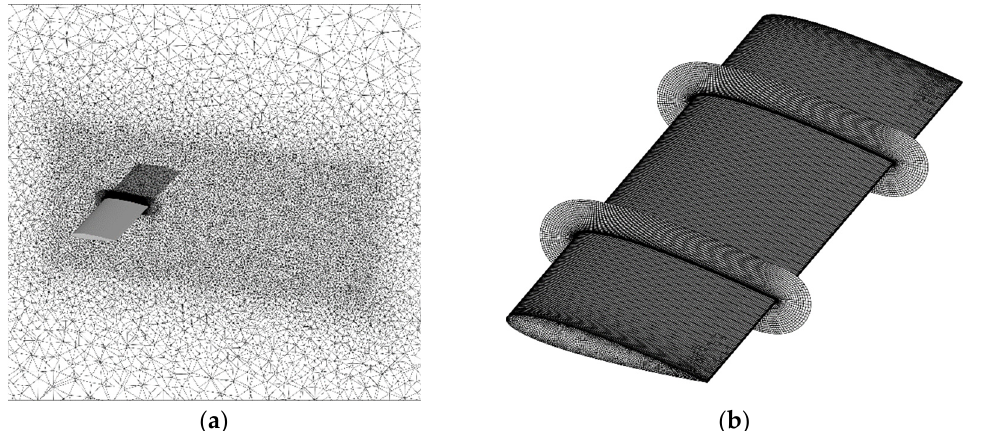
Figure 13. RANSE solver grid: ( a ) Overall view of the spherical domain used for the computational domain spanning 100 chords. The grid is fully unstructured as can be seen by a slice of the grid, as shown above; ( b ) detail of the grid in the near wall vicinity. A slice of the computational mesh is depicted, and a structured-like grid is generated to resolve the boundary layer.